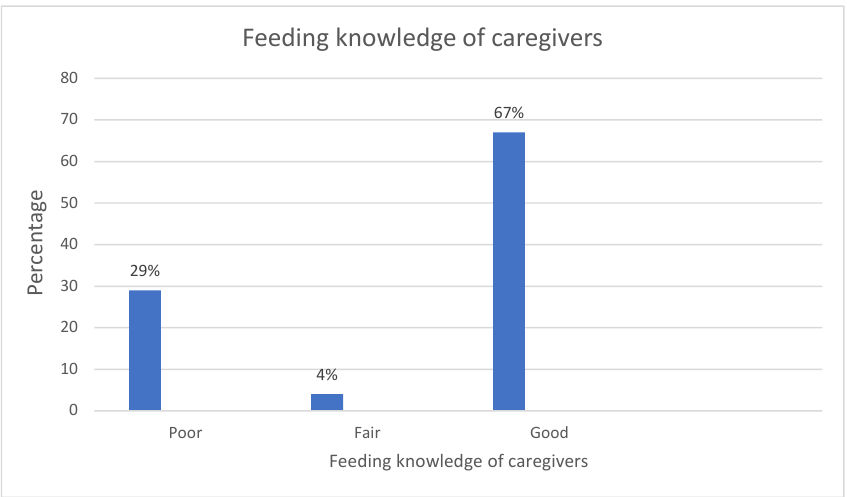
Figure 1. Infant and young child feeding knowledge of caregivers (on a scale of poor (0–50%), fair (51–80%) and good (81–100%).